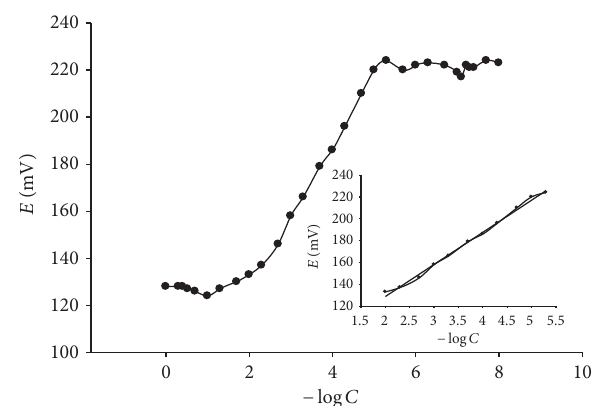
F 9: Potentiometric response of the proposed electrodes towards chromate ion (inset: linear segment (calibration curve) of the electrode